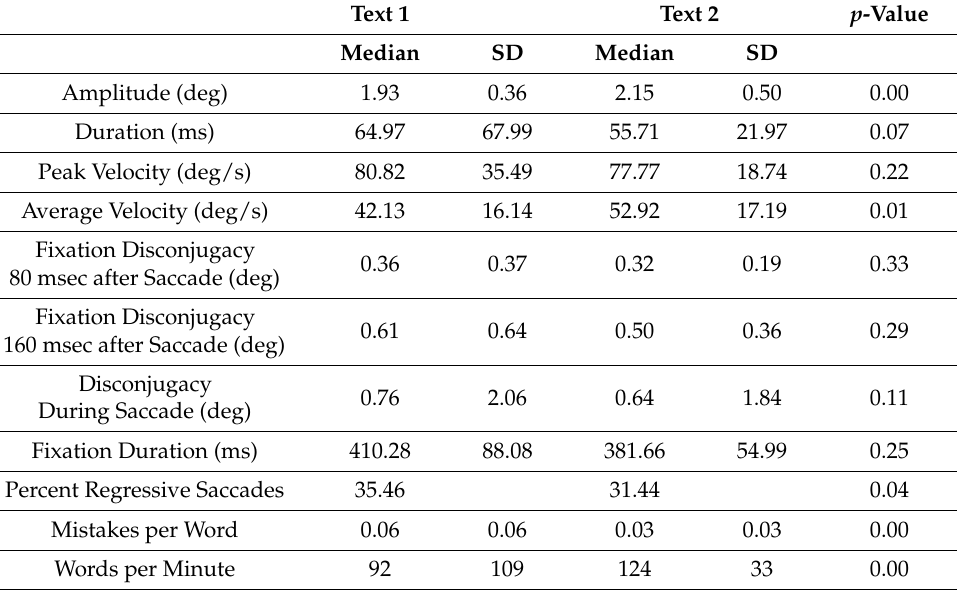
Table 3. Comparing Texts in the Dyslexic